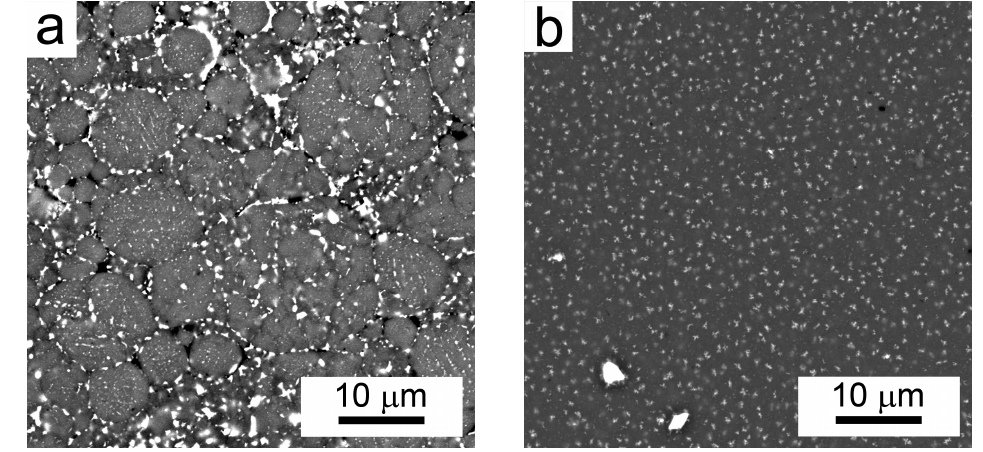
Figure 9. The microstructure of spark plasma sintering (SPS) compacts: ( a ) Al7075Zr_AC compact; ( b ) Al7075Zr_MC compact, BSE contrast.